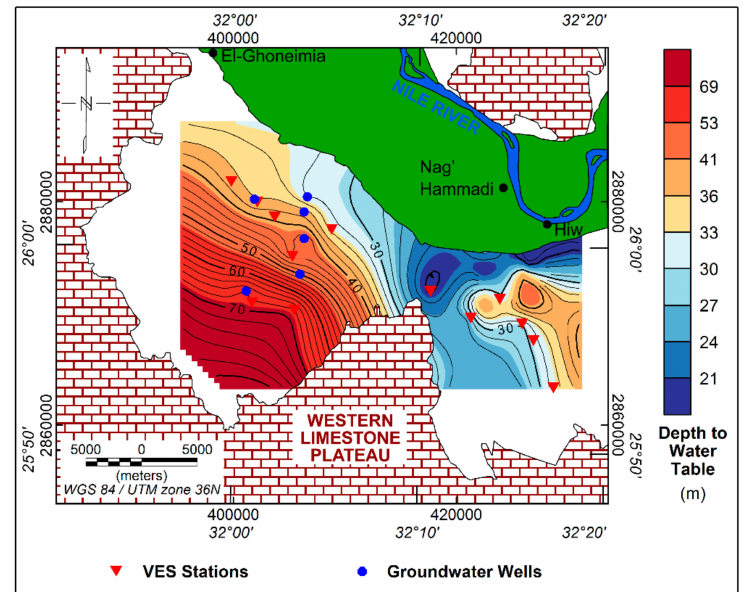
Figure 18. Depth to water contour map inferred from VES data.